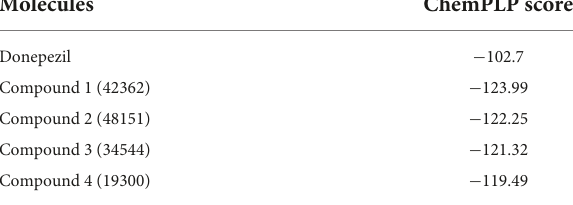
TABLE 2 The ChemPLP binding scores of the reference inhibitor drug and the best predicted active molecules.